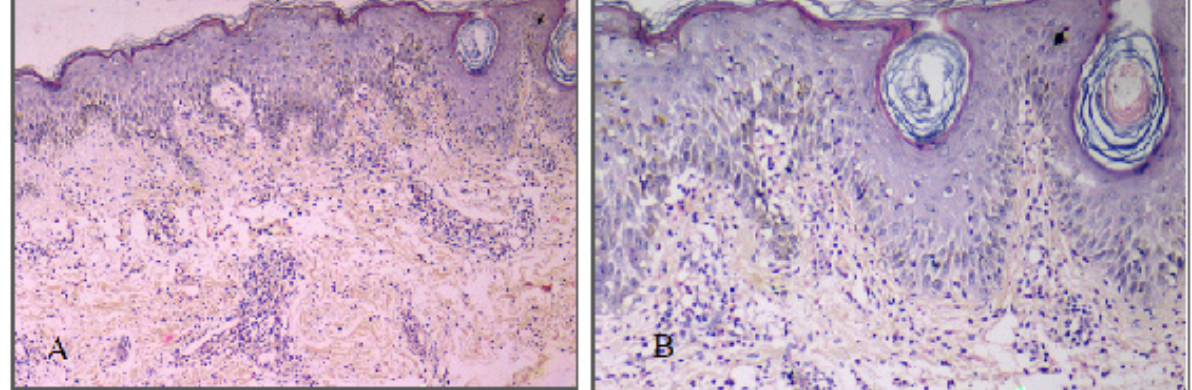
Figure 5: Histopathological Images Showing Orthokeratotis, Mild Spongiosis, Follicular Plugging, Foci of Vacuolar Degeneration of Basal Layer, Exocytosis of Neutrophil in Epidermis with Dense Perivascular Neutrophilicand Lymphocytic Infiltrate with Inflammation in the Interstitium (Hematoxylin And Eosin Staining; Figure 5A: 10X Magnification, Figure 5B: 40X